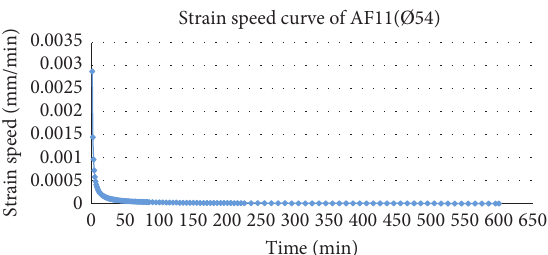
Figure 7: Deformation speed curve of AF11(Ø54) under a load of σ � 16 . 1865 MPa.